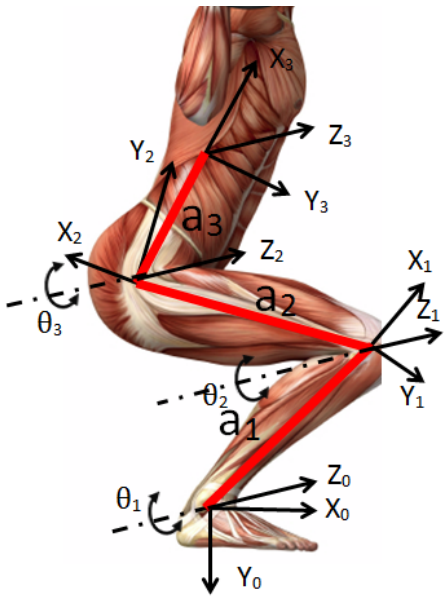
Figure 2. Three degrees-of-freedom kinematic model of the